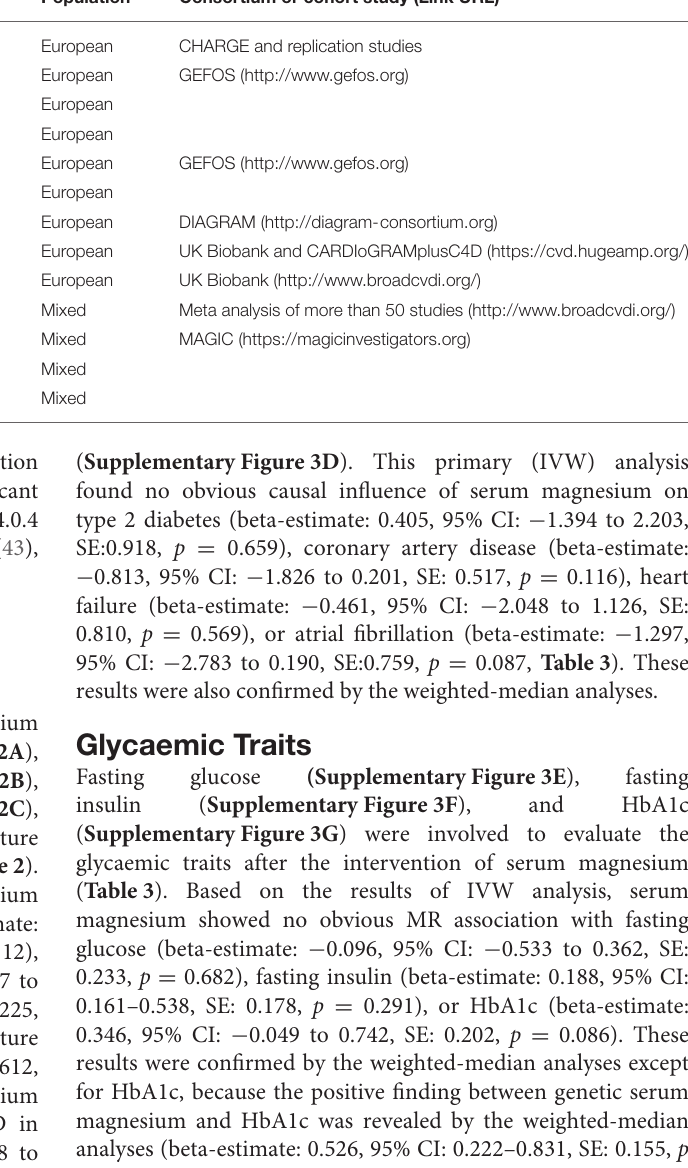
TABLE 1 | Details of studies and datasets used for analyses. Traits